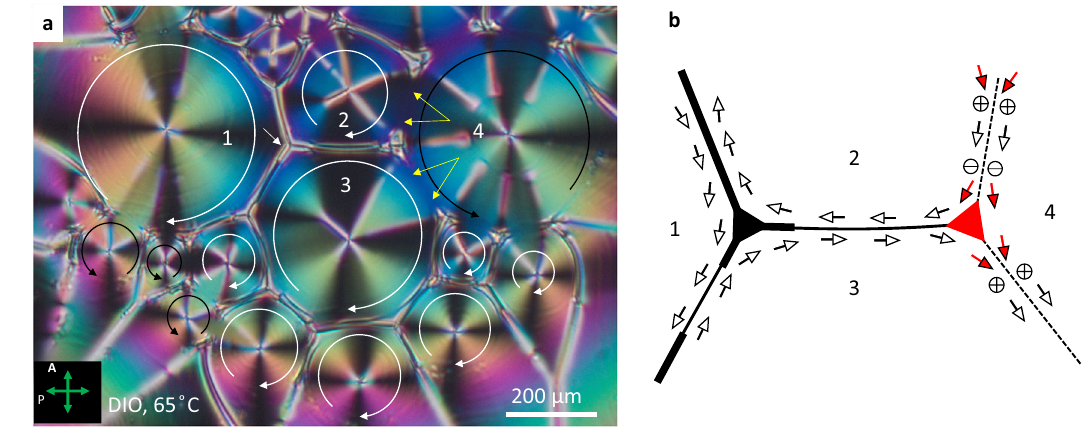
Fig. 5 | Polygonal texture of vortices in an N F fi lm. a Polarizing microscopy texture. The fi lm thickness increases from the center ( h ≈ 5 μ m) to the periphery ( h ≈ 10 μ m). Two neighboring +1 vortices of the same circulation direction are separated by H- and T-walls, while two domains of an opposite circulation show a relativelysmoothtransitionwithsplayregions(shownbyyellowarrows).Whiteand